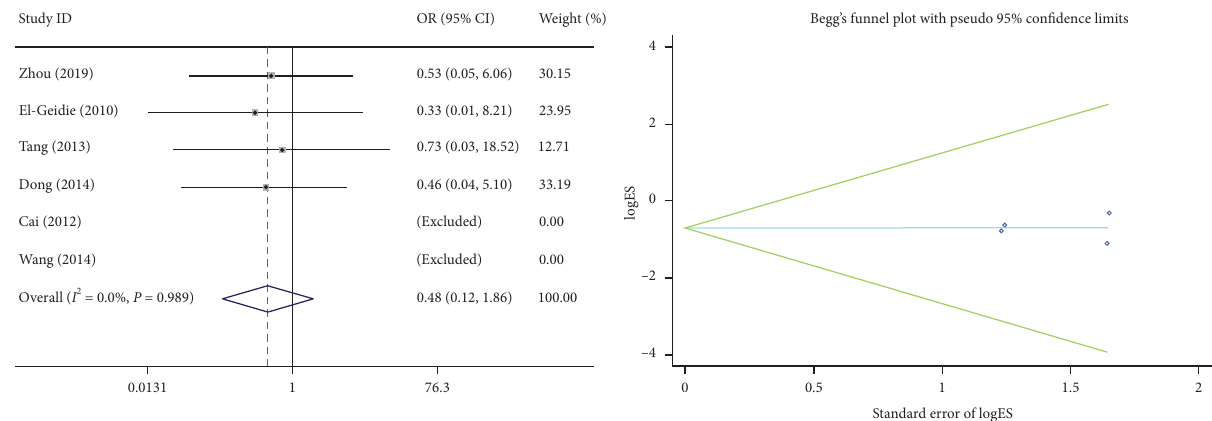
F IGURE 7: Forest plot and funnel plot of the postoperative bleeding between the primary suture group and the T-tube drainage